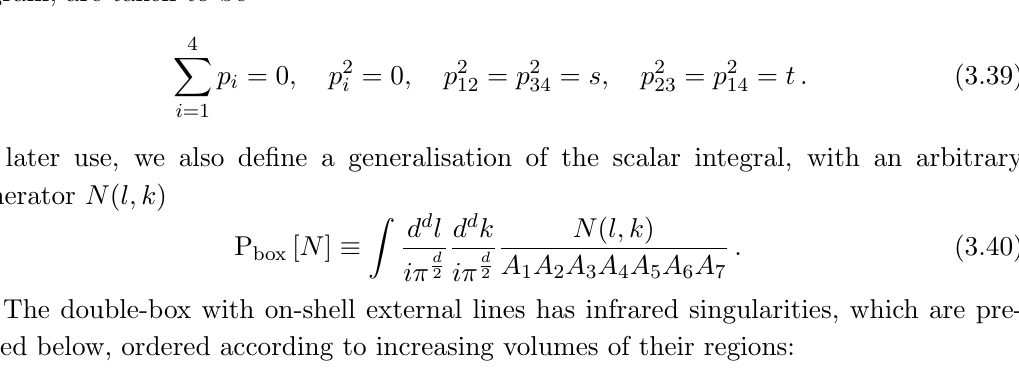
Figure 1 . The two-loop planar box